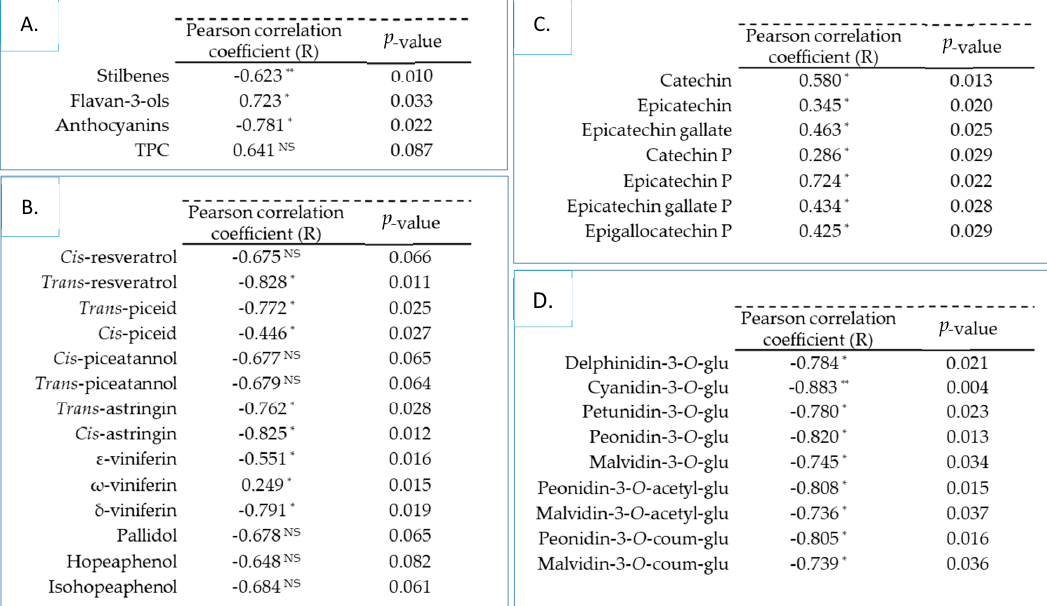
Figure 4. Pearson’s correlation coe ffi cient (with α = 0.05) between α -glucosidase inhibitory activity of all skin and seed Tannat grape extracts and total polyphenol families ( A ), stilbene ( B ), flavan-3-ol ( C ) and anthocyanin ( D ) compounds. * Indicates significance at p ≤ 0.05, ** Indicates significance at p ≤ 0.01. NS = Non-Significant, TPC = Total Polyphenol Content, glu = glucoside, coum = coumaroyl, P =